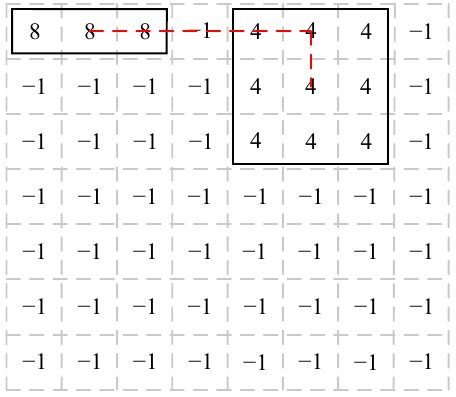
Figure 7. Chiplet spacing calculation method.